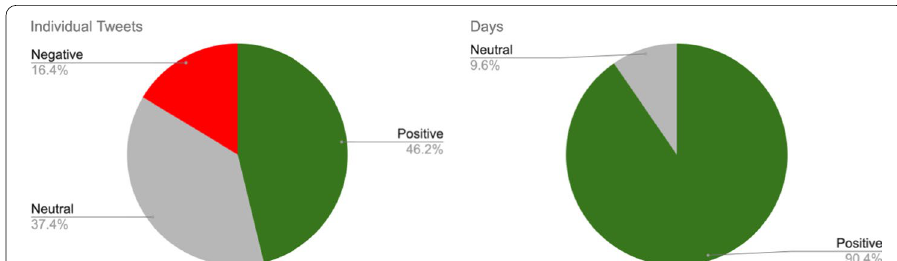
Fig. 11 Tweet sentiment polarity